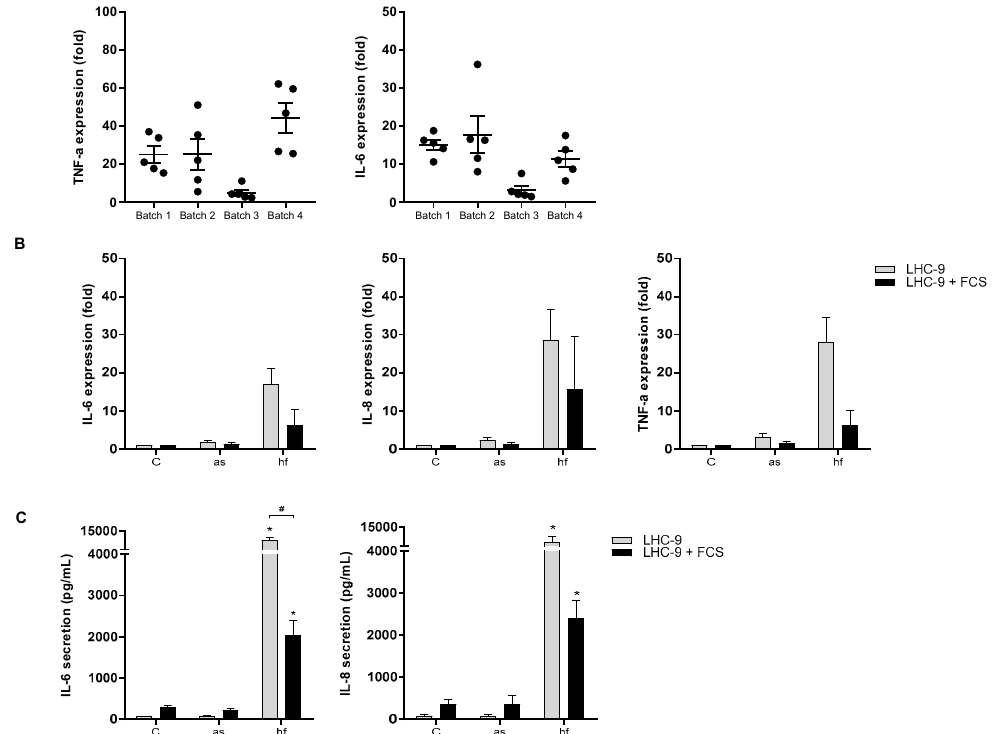
Figure 2. Batch variations and effects of serum on cytokine/chemokine expression and release. ( A ) BEAS-2B cells were exposed to 100 µg dry weight/mL of four different batches of X-ray treated P. chrysogenum hyphal fragments (hf) for 6 h. The mRNA level of TNF- α and IL-6 were assessed by real time RT-PCR. Medium blanks were included as control. Plots represent mean ± SEM of 5 independent experiments. ( B ) BEAS-2B cells grown in LHC-9 media ± FCS were exposed to X-ray treated aerosolized spores (as) and hyphal fragments (hf) 100 µg dry weight/mL from P. chrysogenum for 6 h and assessed for expression with real-time RT-PCR or ( C ) cytokine/chemokine release analyzed by ELISA. Medium blanks were included as control. The results represent mean ± SEM of two or three independent experiments respectively. Statistical analyses were performed by two-way ANOVA with Dunnett’s/Sidak post-tests on log transformed data. Significant difference denoted by * (individual control vs exposed) or # (±FCS), p < 0.05.